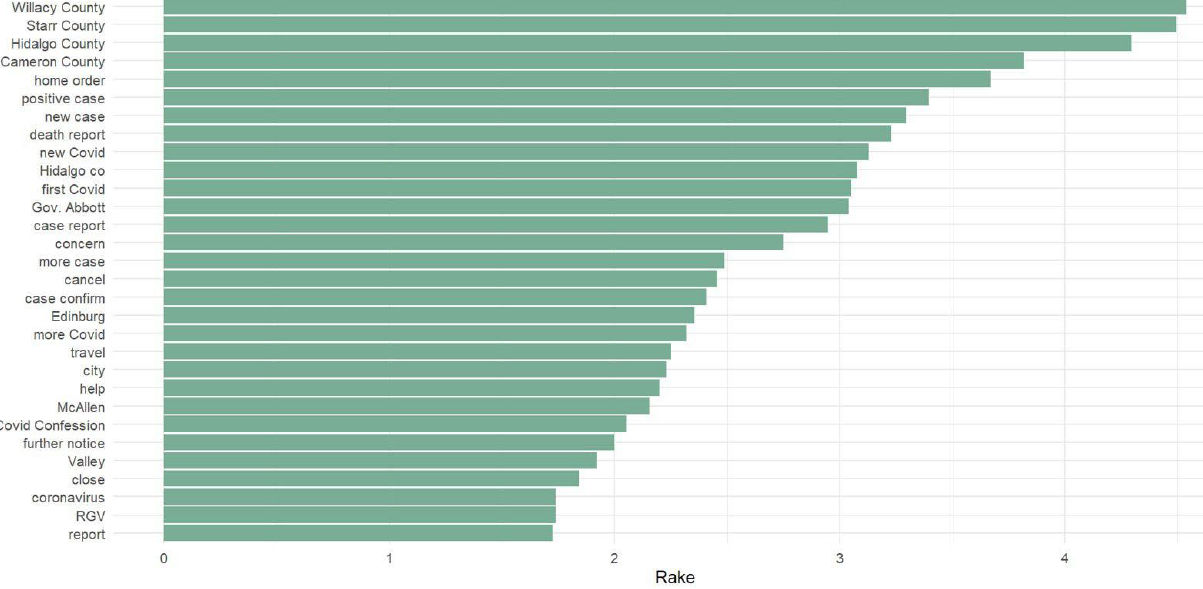
Figure 8. Keywords (noun, pronoun, verb, adjective) identified by RAKE (The Monitor).